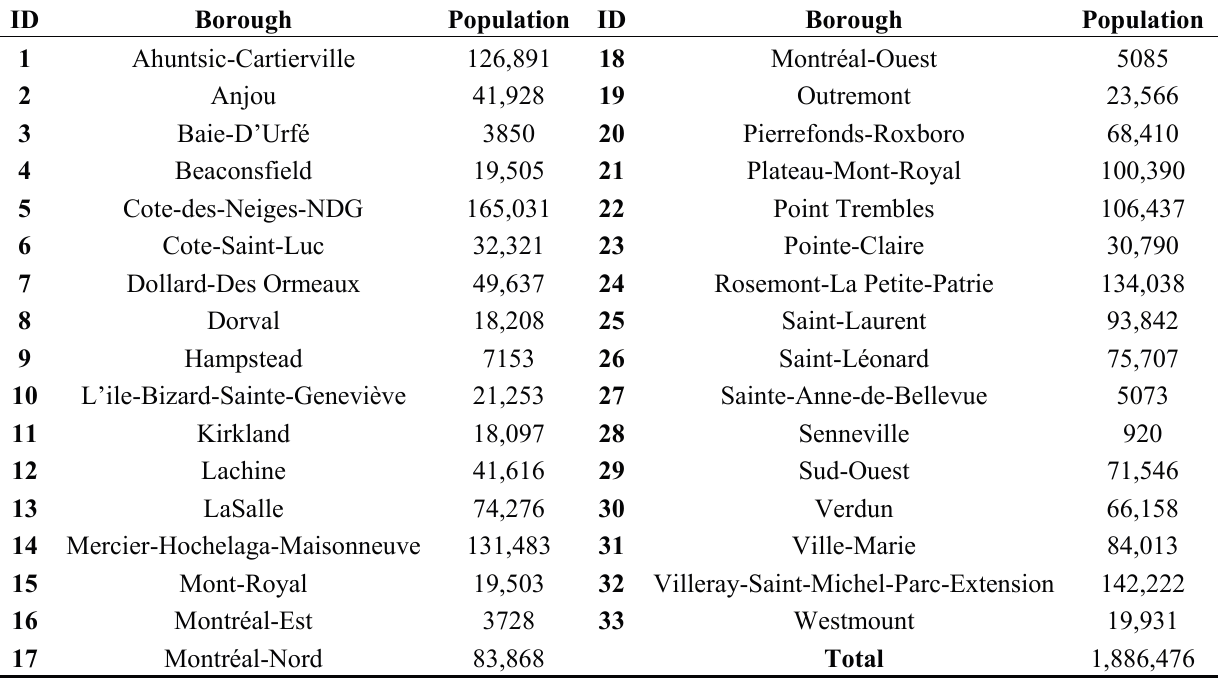
Table 4. Montréal boroughs and their associated